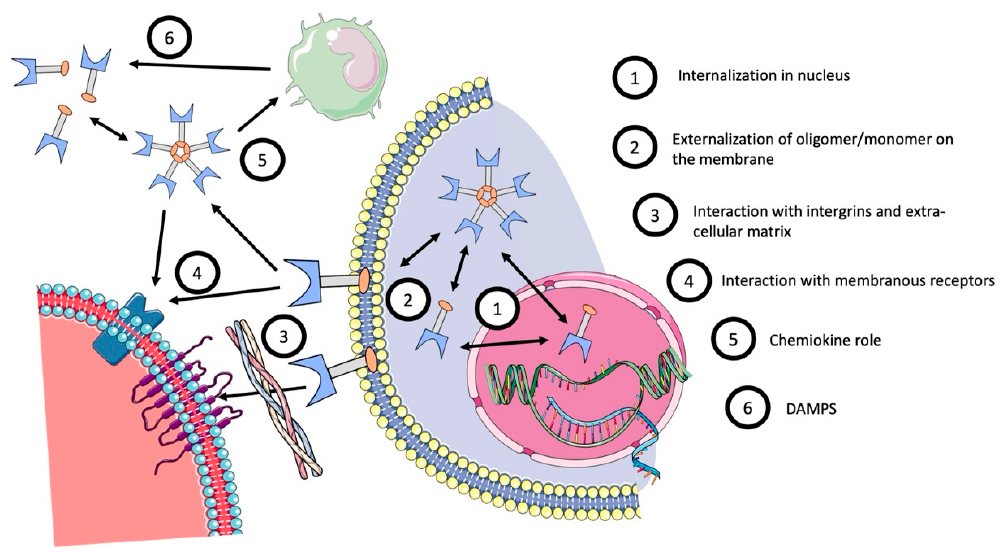
Figure 2. Galectin-3’s role and localization.